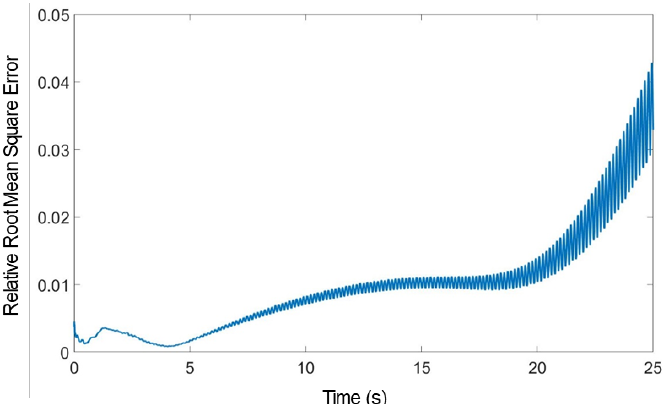
Figure 7. Example 1: RRMSEs of the proposed method from OpenFOAM.